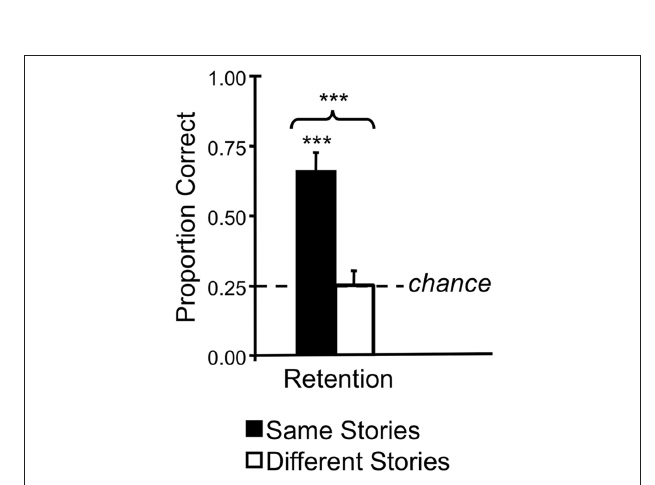
Figure 5 | results from the retention trials. The y -axis represents proportion of correct choices on the four-alternative test trials. The dotted line represents chance (0.25). Error bars represent one standard error of the mean. * p < 0.05, ** p < 0.01, *** p < 0.001.